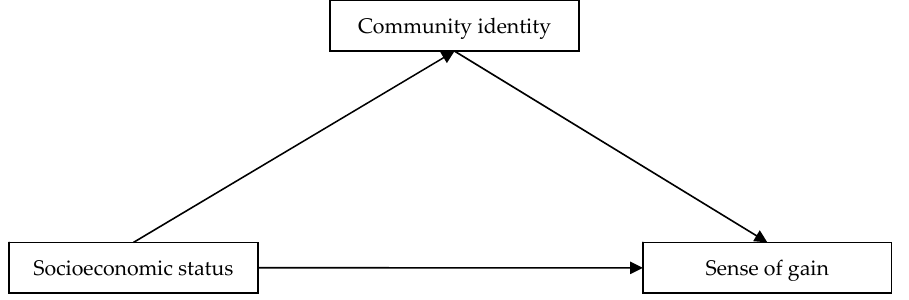
Figure 1 . Basic model of the relationship between socioeconomic status and sense of gain as mediated by community identity.